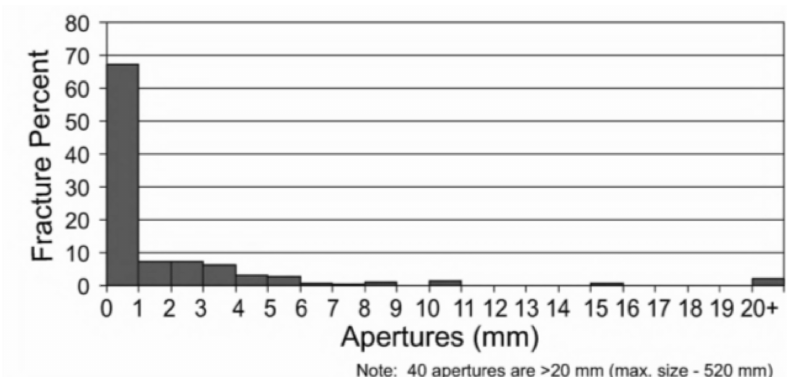
Figure 4. Yucca Mountain cross-drift fracture aperture statistics, see Mongano et al. (1999). Total number of fractures mapped, N =